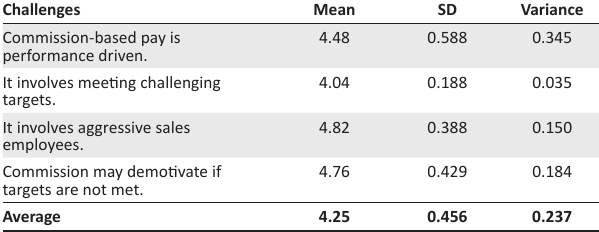
TABLE 7: The challenges in commission-based pay for retention.